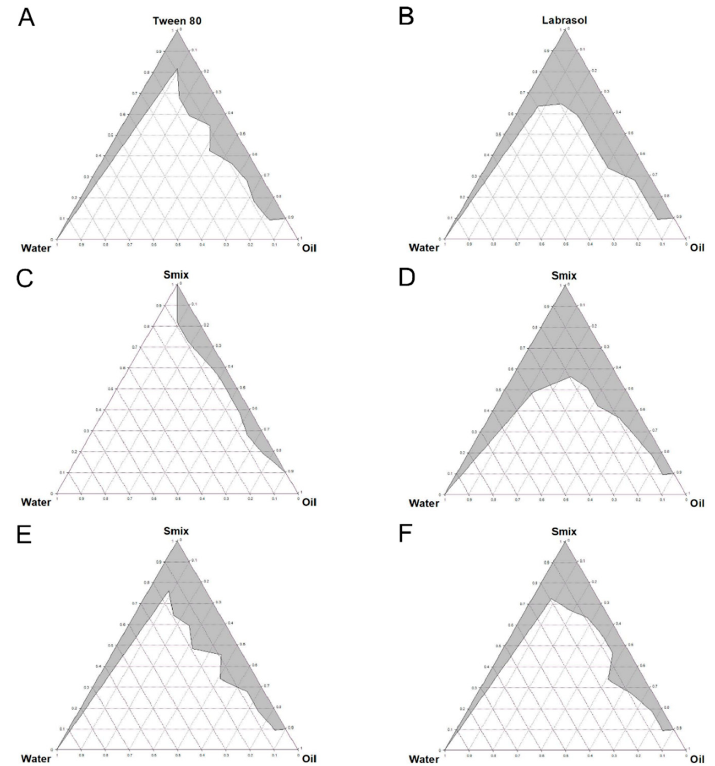
Figure 2. Pseudo-ternary phase diagrams composed of water, oil (olive oil) and surfactant. ( A ) Tween 80; ( B ) Labrasol; ( C ) Labrasol/ethanol (0.5/1, v / v ); ( D ) Labrasol/ethanol (1/1, v / v ); ( E ) Labrasol/ethanol (2/1, v / v ); ( F ) Labrasol/ethanol (4/1, v / v ).